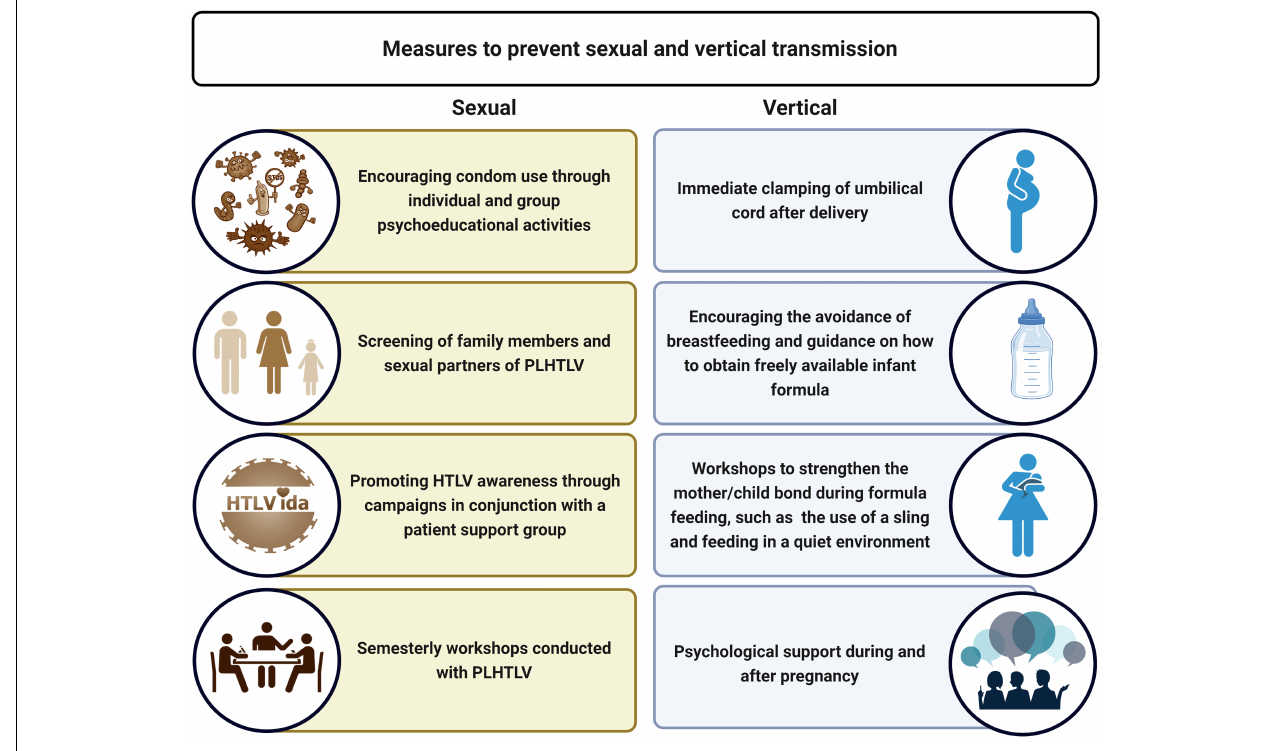
FIGURE 3 | Actions conducted by the Integrated Multidisciplinary HTLV Center (CHTLV) to prevent sexual and vertical transmission. HAM/TSP, HTLV-1-associated myelopathy/tropical spastic paraparesis; KCS, keratoconjunctivitis